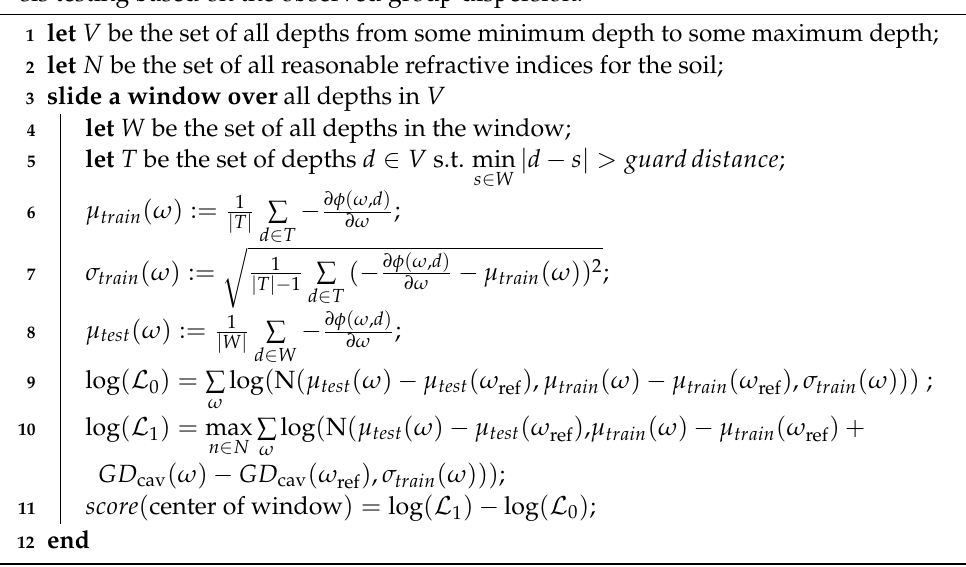
Algorithm A1 CFAR-style algorithm for performing Neyman-Pearson hypothe- sis testing based on the observed group